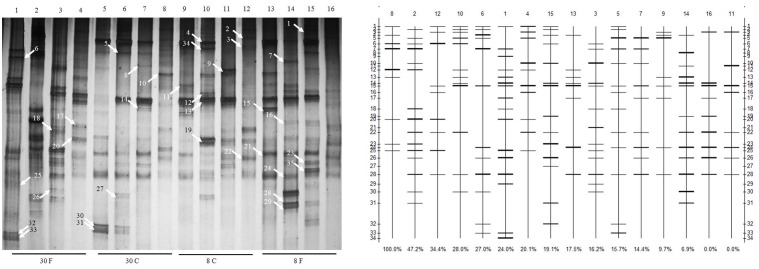
Changes in the structure and degradation capability of stains and cluster analysis of denaturing gradient gel electrophoresis (DGGE) profiles of communities from different hens fed in different patterns with age growing. Duodenum, jejunum, ileum, and cecum samples from: 30-week-old, free range hens (lanes 1–4); 30-week-old, caged hens (lanes 5–8); 8-week-old, caged chickens (lanes 9–12); 8-week-old, free range chickens (lanes 13–16). A total of 35 isolates were detected in the small intestines, and different bands were observed in different intestinal parts of different chickens. Denaturing gradient gel electrophoresis profiles illustrate the structure of the communities. The profiles and bands of DGGE were analyzed using Quantity One software 4.3. The clustering method is by unweighted pair-group method with arithmetic means.